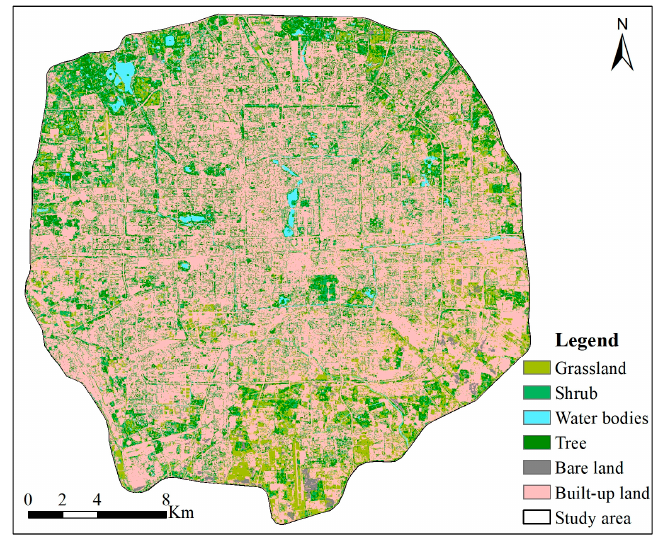
Figure 2. Land use and land cover map of the study area, 2019.